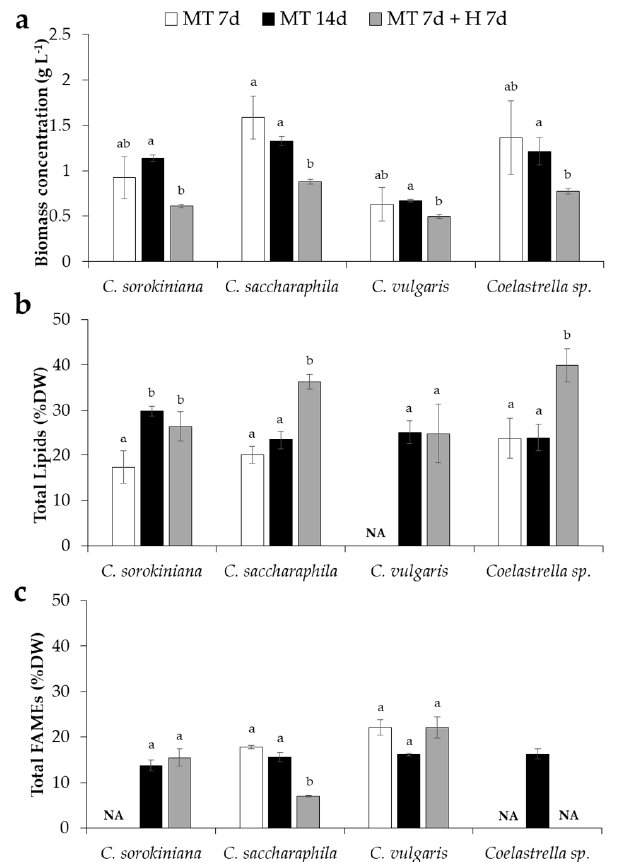
Figure 1. ( a ) Biomass concentration (g L − 1 ) ( n = 4); ( b ) total lipids (% dry weight–DW), n = 4; and ( c )